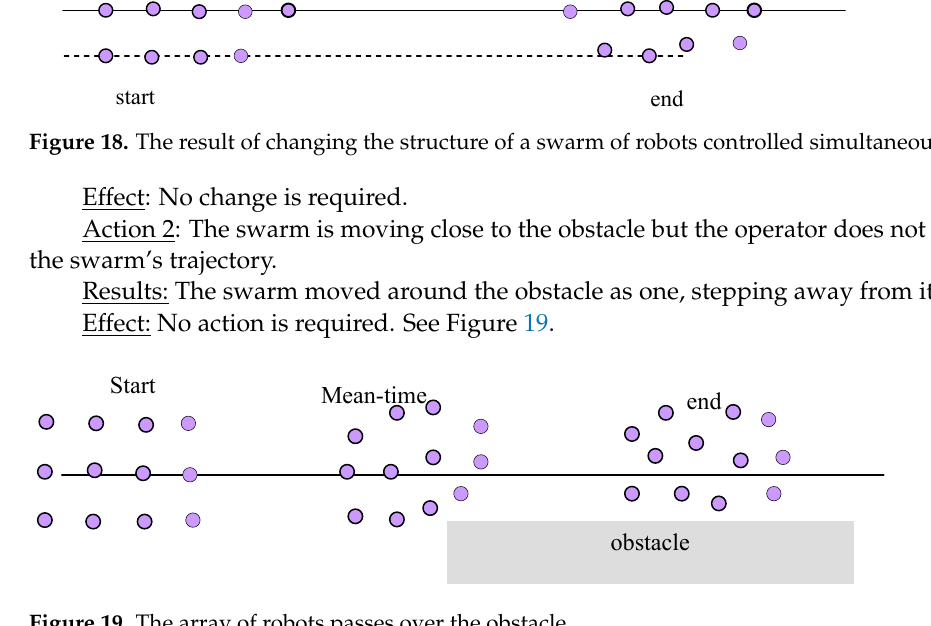
Figure 19. The array of robots passes over the obstacle. Action 3 : The swarm enters between two